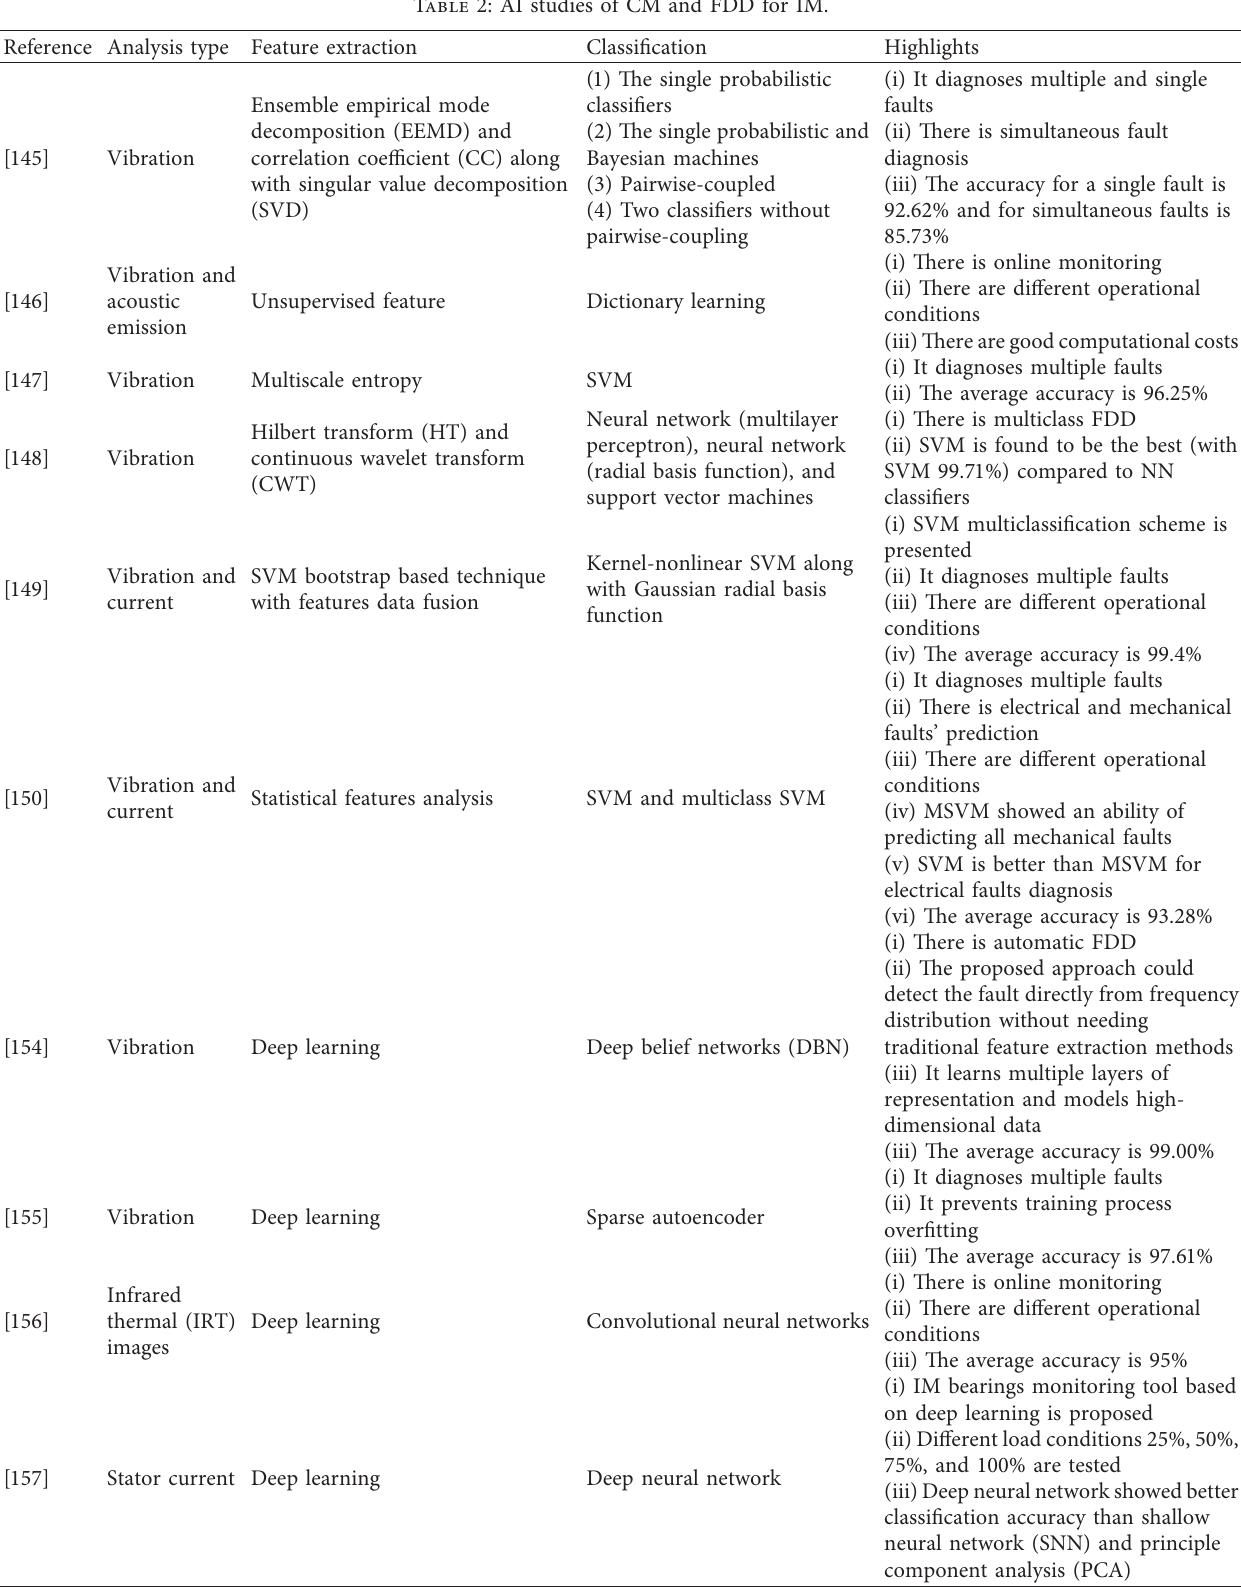
Table 2: AI studies of CM and FDD for